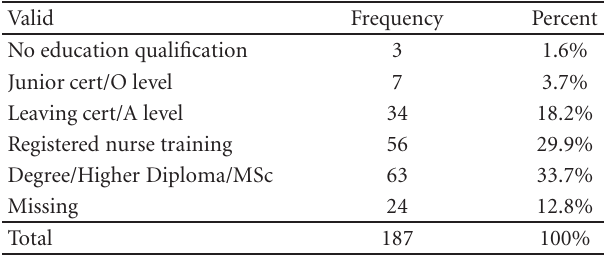
Table 1: Highest education